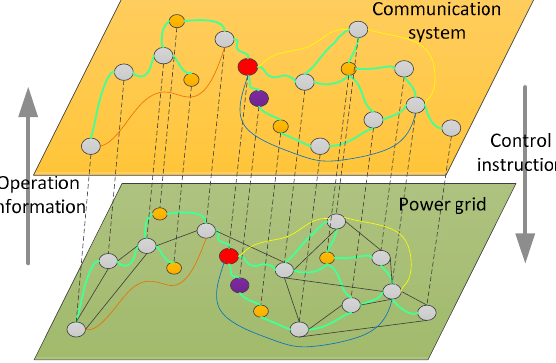
Figure 3. The interdependency between the communication system and power grid.